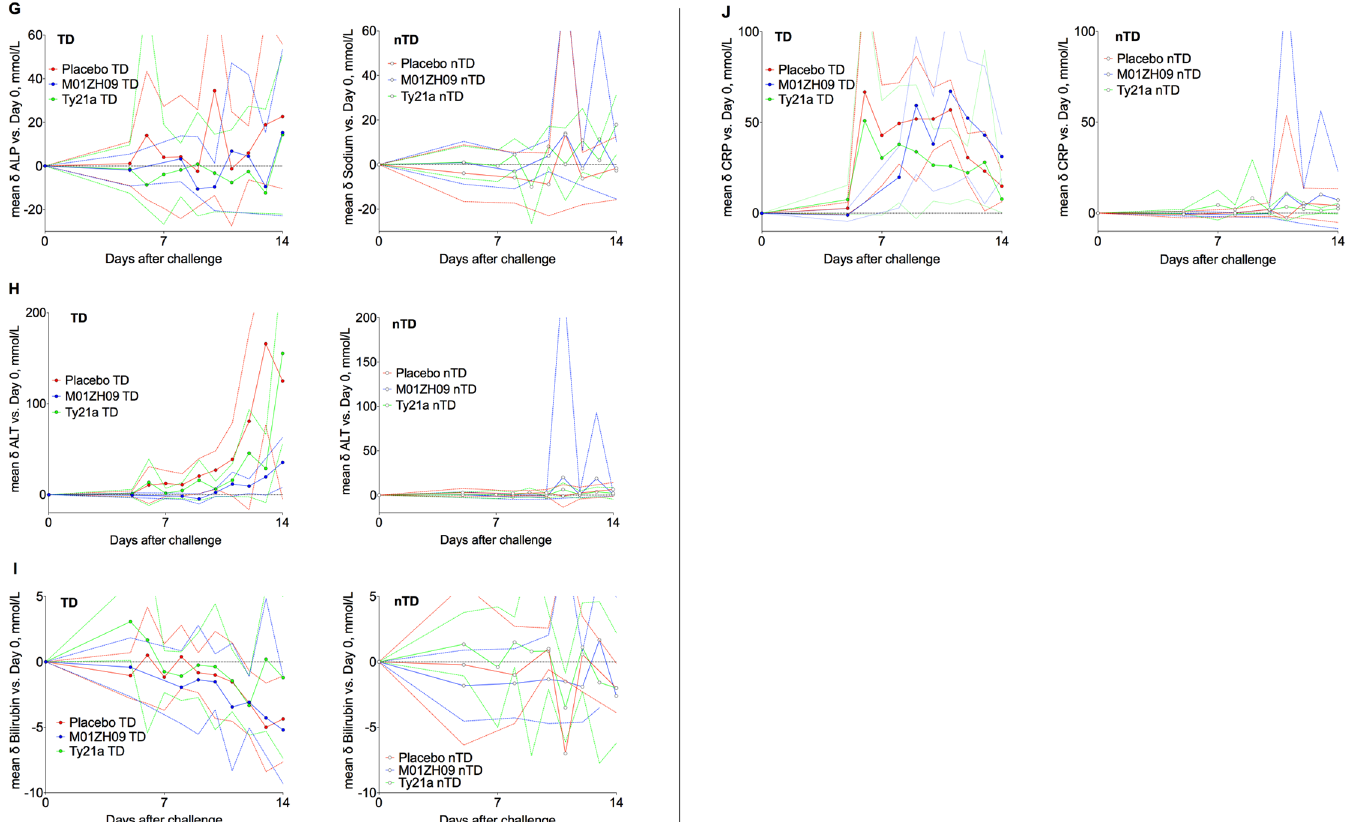
Fig 7. Group mean changes (95% confidence intervals) in biochemistry blood parameters compared to individual baseline measurements according to vaccine allocation and challenge outcome. (A) Sodium, (B) potassium, (C) urea, (D) creatinine, (E) Albumin, (F) amylase, (G) alkaline phosphatase, (H) alanine aminotransferase, (I) bilirubin, and (J) C-reactive protein. TD, typhoid diagnosis; nTD, non-typhoid diagnosis.